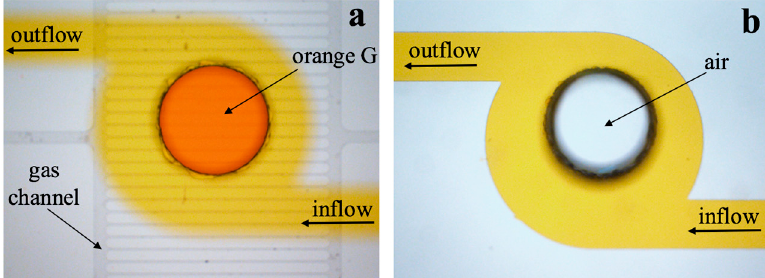
Figure 4. Characterization of orange solution injecting process and the function of gas channel. ( a ) Liquid loading into the chamber with the array of gas channel. Orange G was easily loaded into culture chamber. ( b ) Liquid failed to be loaded into the chamber without gas channel. The culture chamber was empty, and orange G passed through the channel.